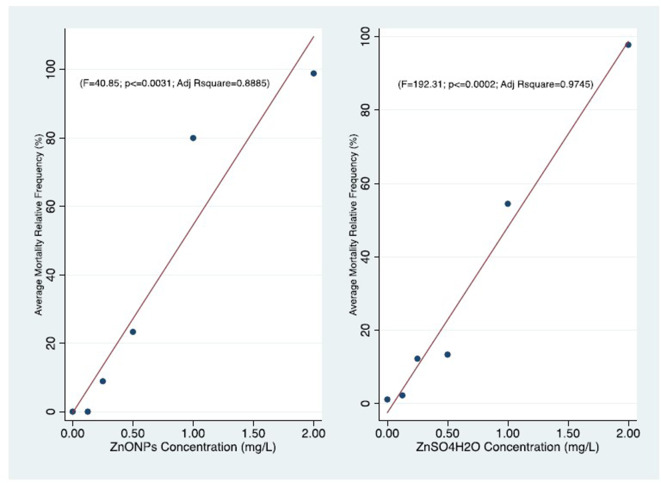
Comparison of concentration-effect curves of T. fulvus after 96 h of exposure to ZnONPs (r = 0.95; P ≤ 0.031) and ZnSO4H2O (r = 0.98; P ≤ 0.002).